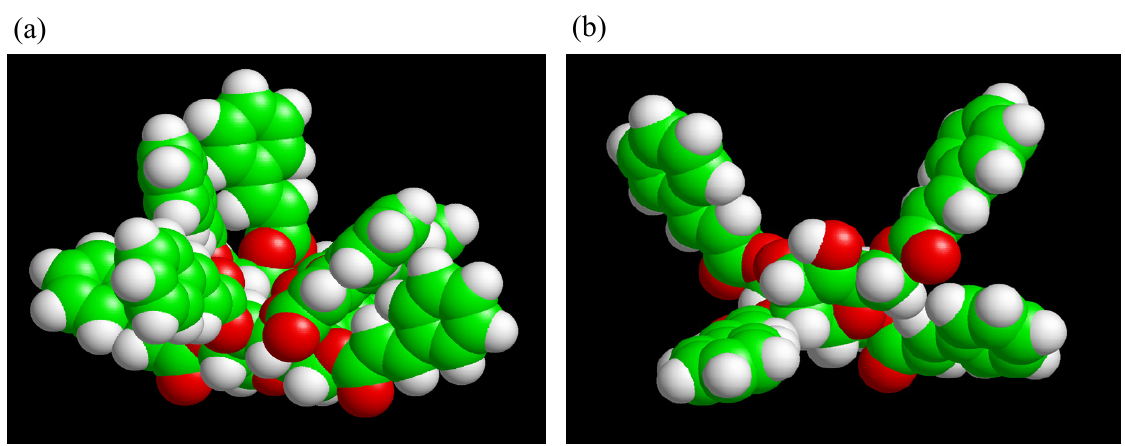
Figure 10. Molecular modeling of (a) TC8 and (b) TC4 optimized by MOPAC PM3 calculation (reproduced from the reference [224] with the permission of John Wiley &